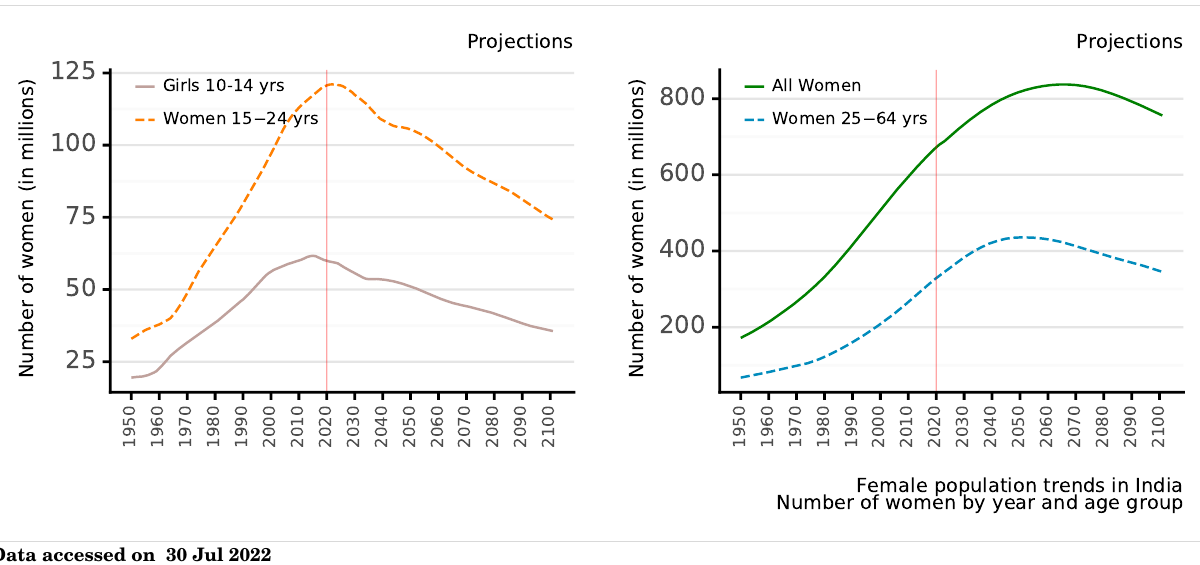
Figure 3: Population trends in four selected age groups in